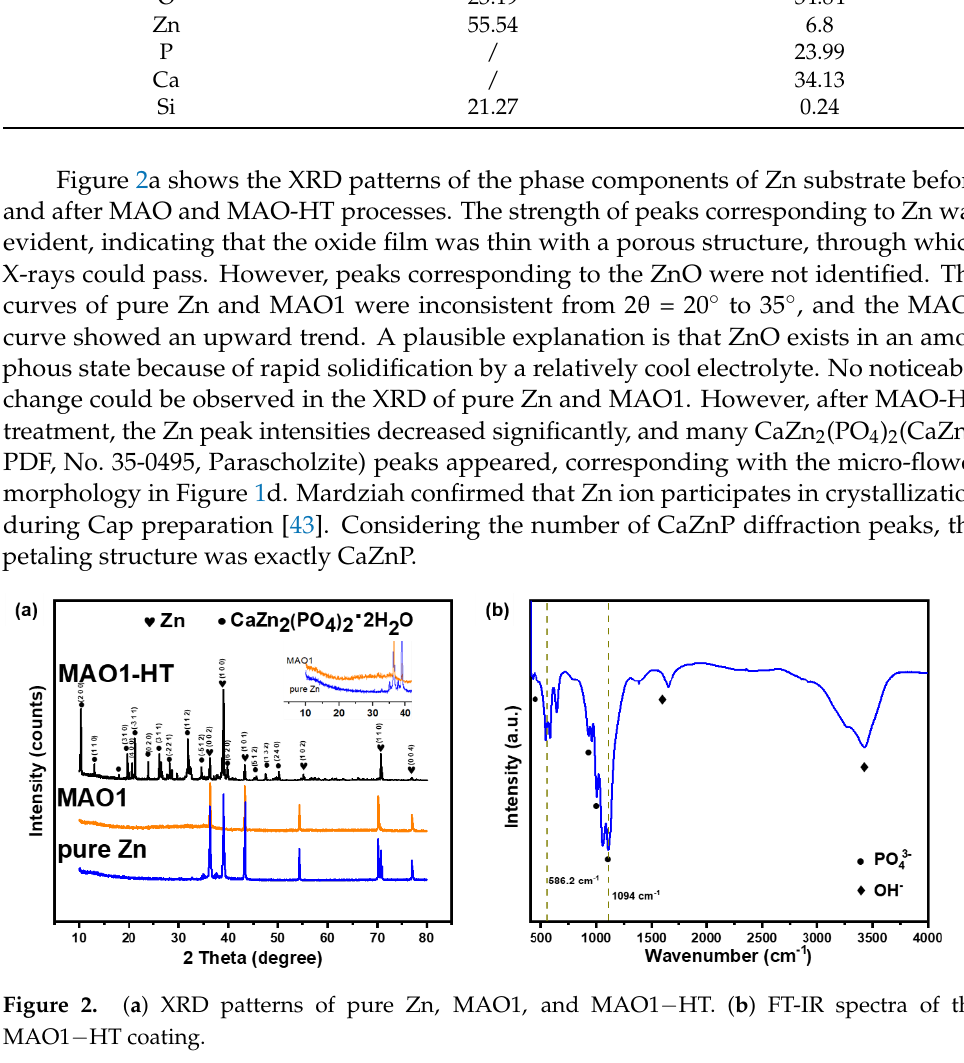
MAO1 − HT coating.